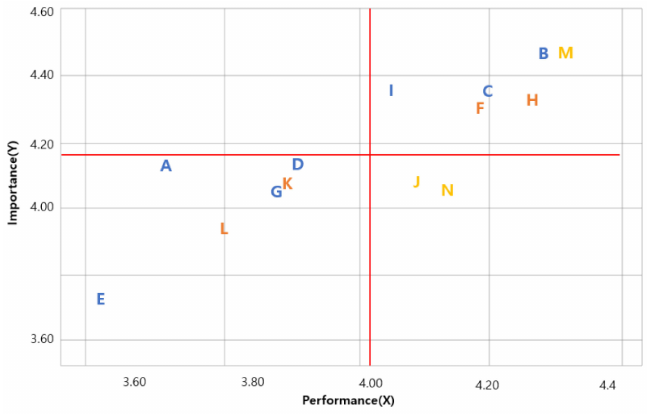
Figure 6. IPA (older adult group).